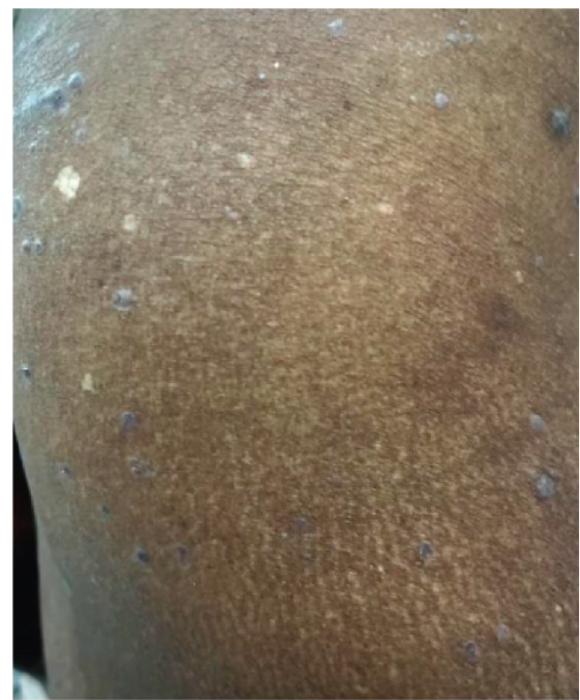
Figure 3: Improvement of the lichen planus lesions over the shoulders.